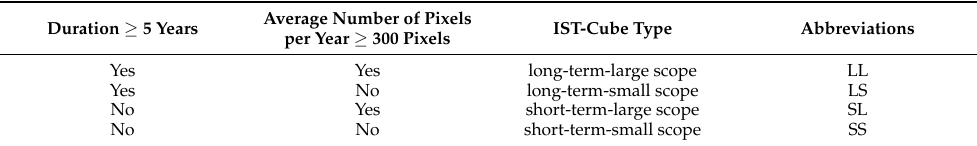
Table 1. IST-cube classification and abbreviations based on spatiotemporal